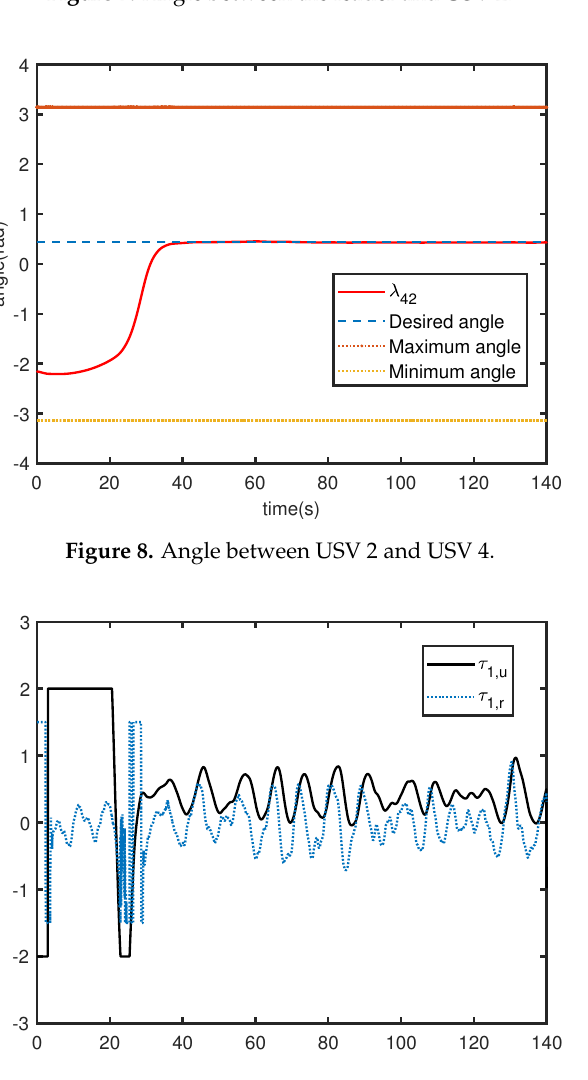
Figure 7. Angle between the leader and USV 2.